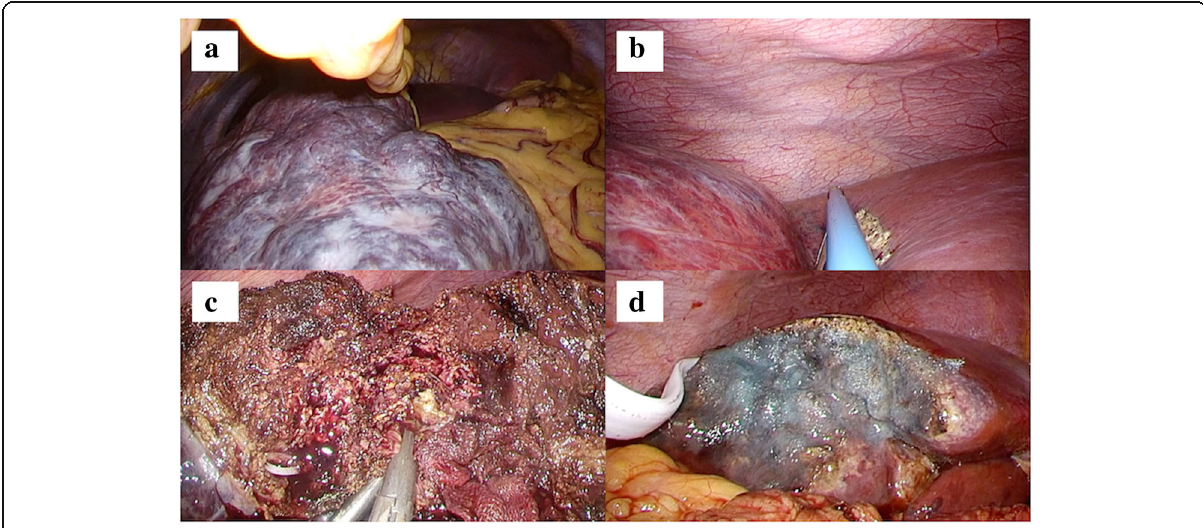
Fig. 3 a The giant hemangioma occupying the entire space of the right upper abdomen was observed from the umbilical laparoscopic view. b A straight transection cutline was marked on the liver surface from the left upper laparoscopic view. c Hepatic transection. d After the resection, a drainage tube was placed adjacent to the resection margin